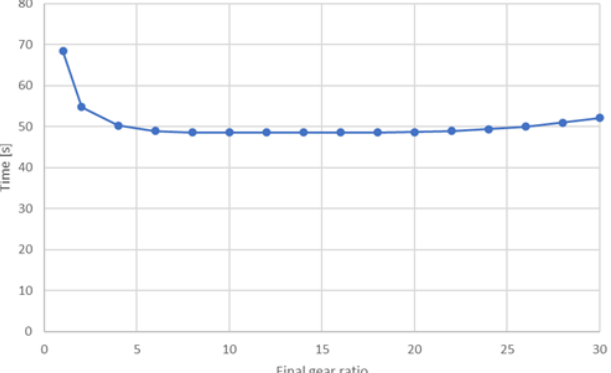
Figure 16. Relationship between final gear ratio and lap time.